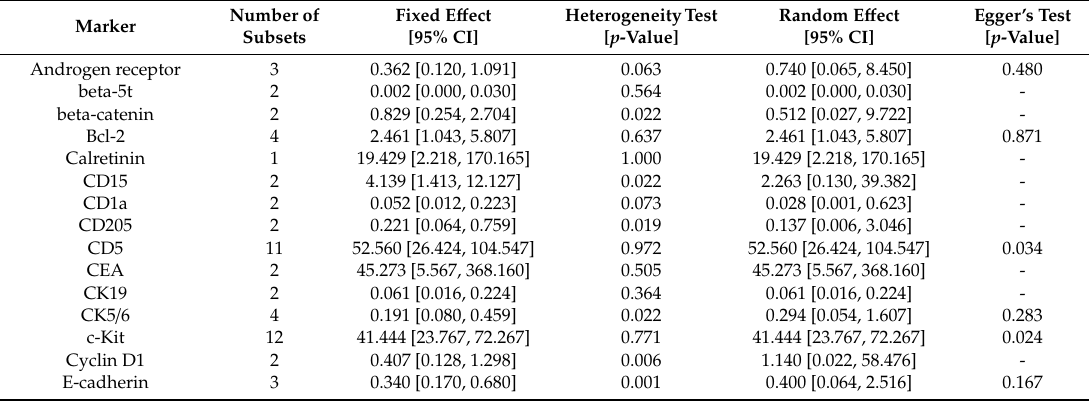
Table 2. Meta-analysis for the odds ratio of various immunohistochemical expressions between thymic carcinoma and